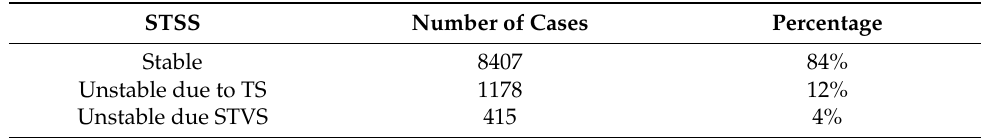
Table 3. Off-line STSS assessment